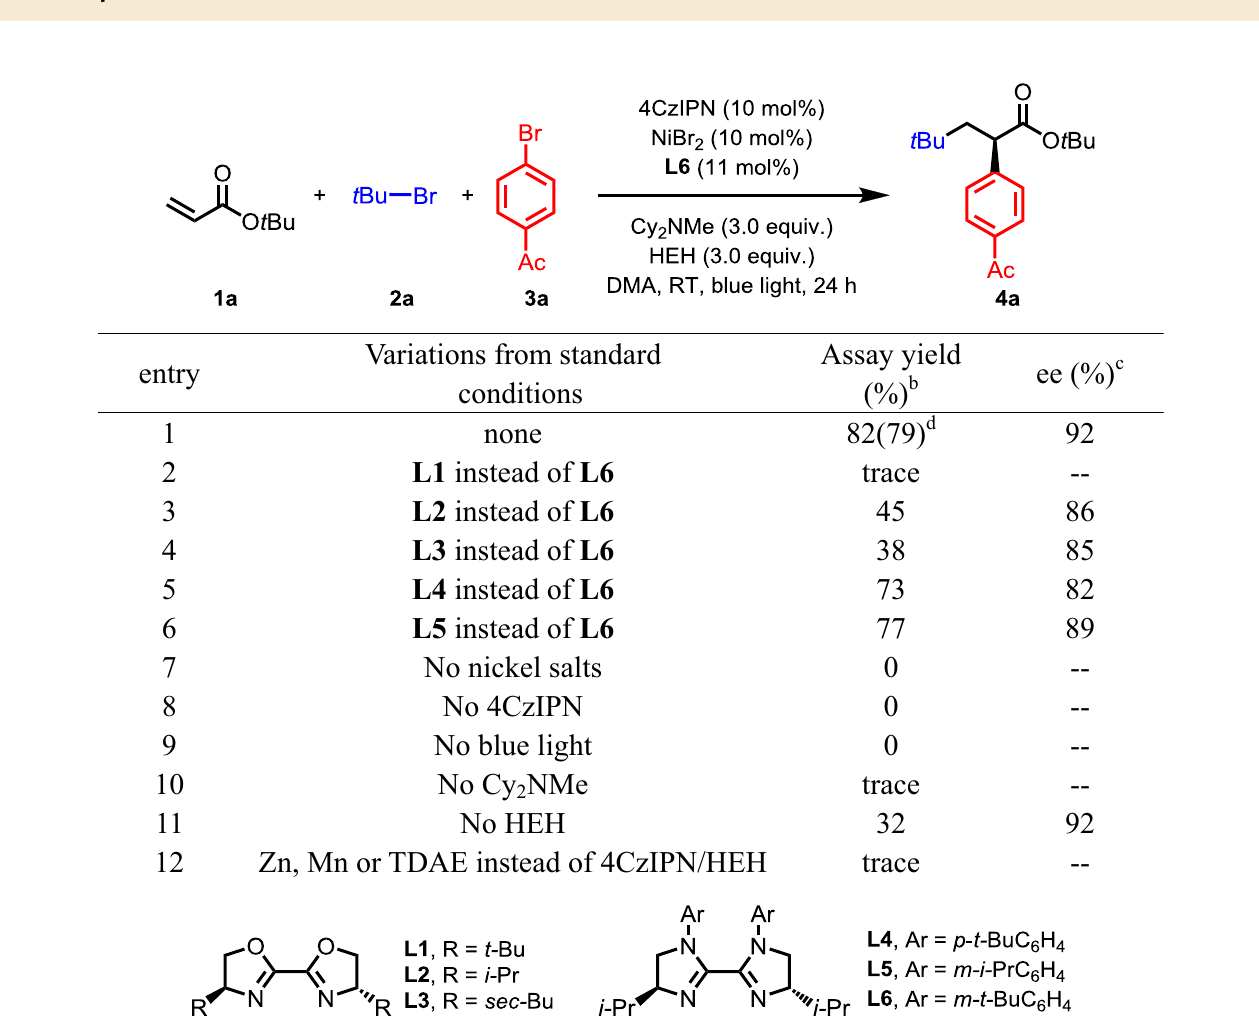
Table 1 Optimization of reaction conditions [a]